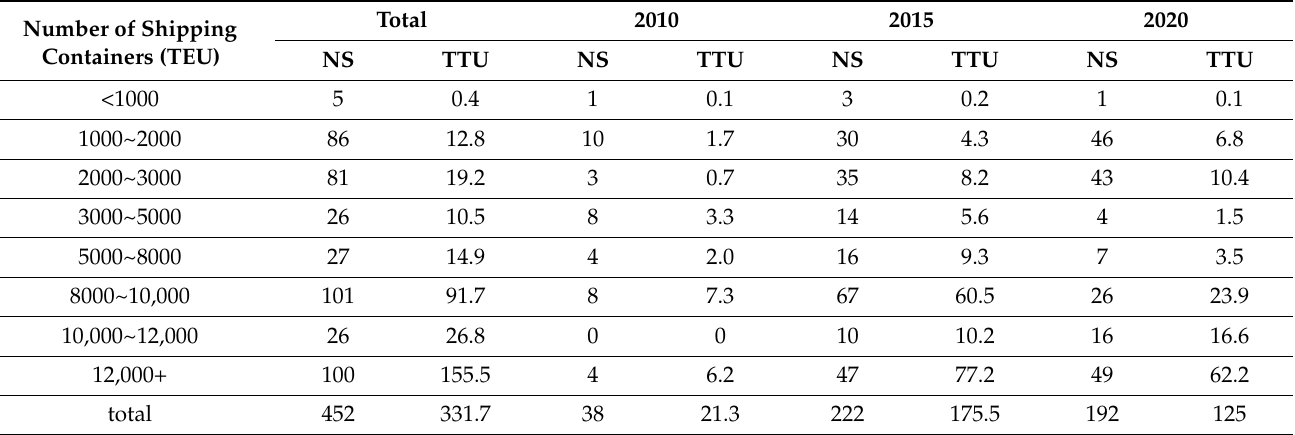
Table 2. The details of the world’s cold chain container ship